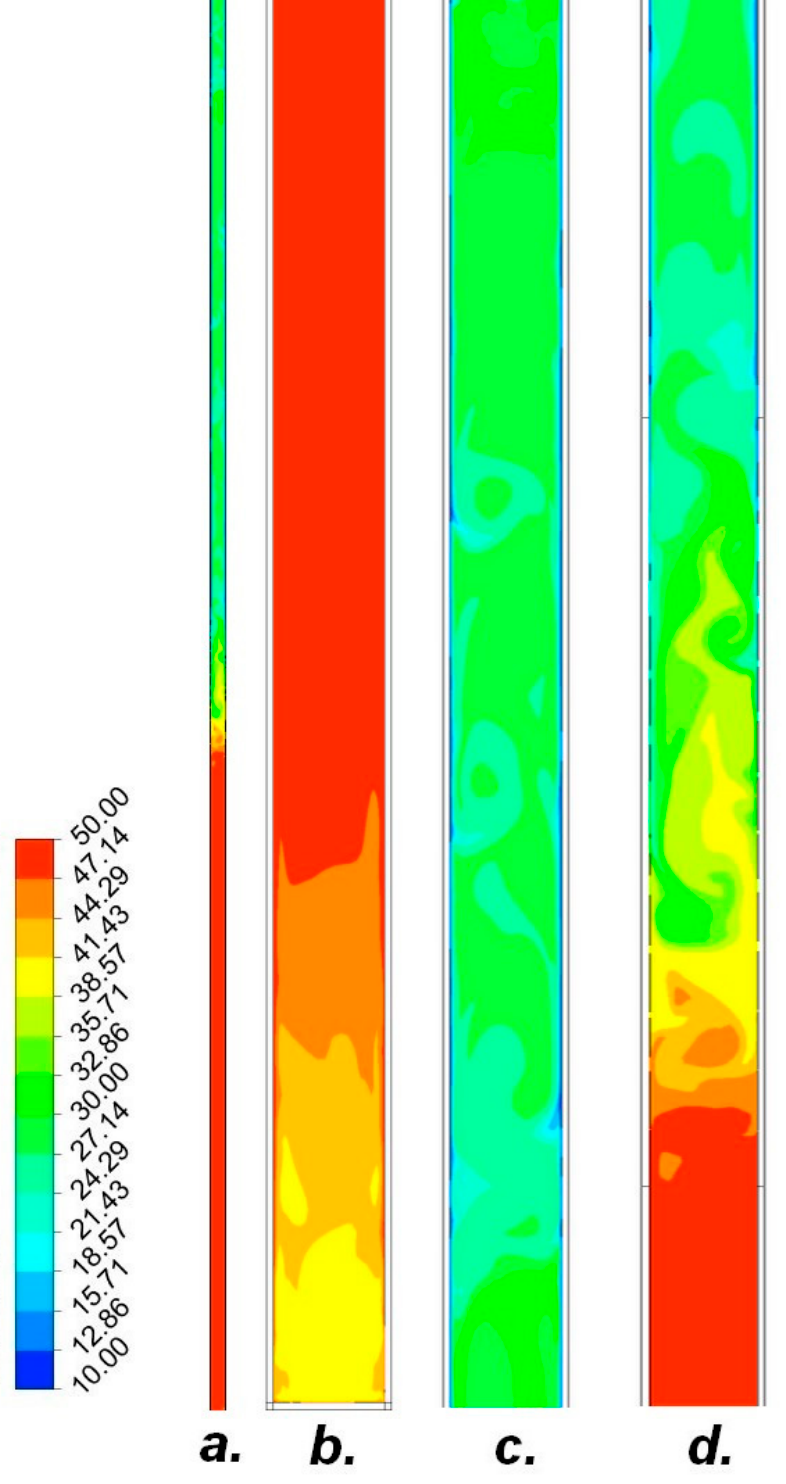
Figure 17. Temperature distribution in the heat pipe. ( a ) Total heat pipe; ( b ) evaporator section; ( c ) condenser section; ( d ) isothermal section.